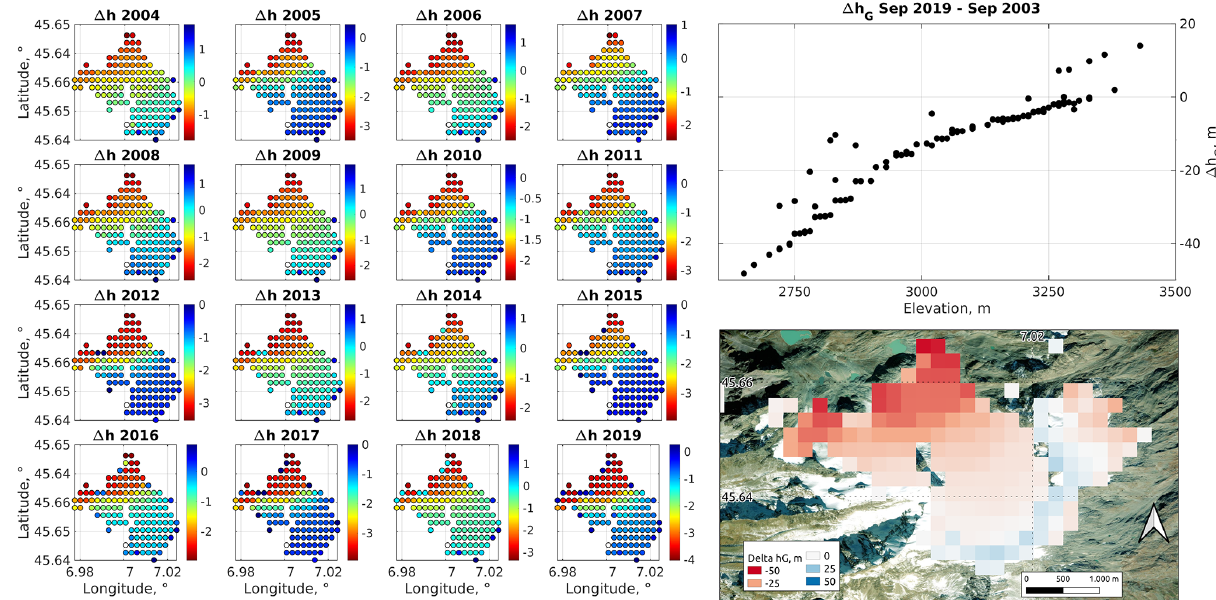
Figure 10. Rutor glacier: spatial patterns of annual change in glacier thickness (left), cumulative change in glacier thickness between Septem- ber 2003 and 2019 as a function of pixel elevation (right, top), and spatial distribution of this cumulative change (right, bottom). The back- ground layer is from the ESRI Satellite theme.